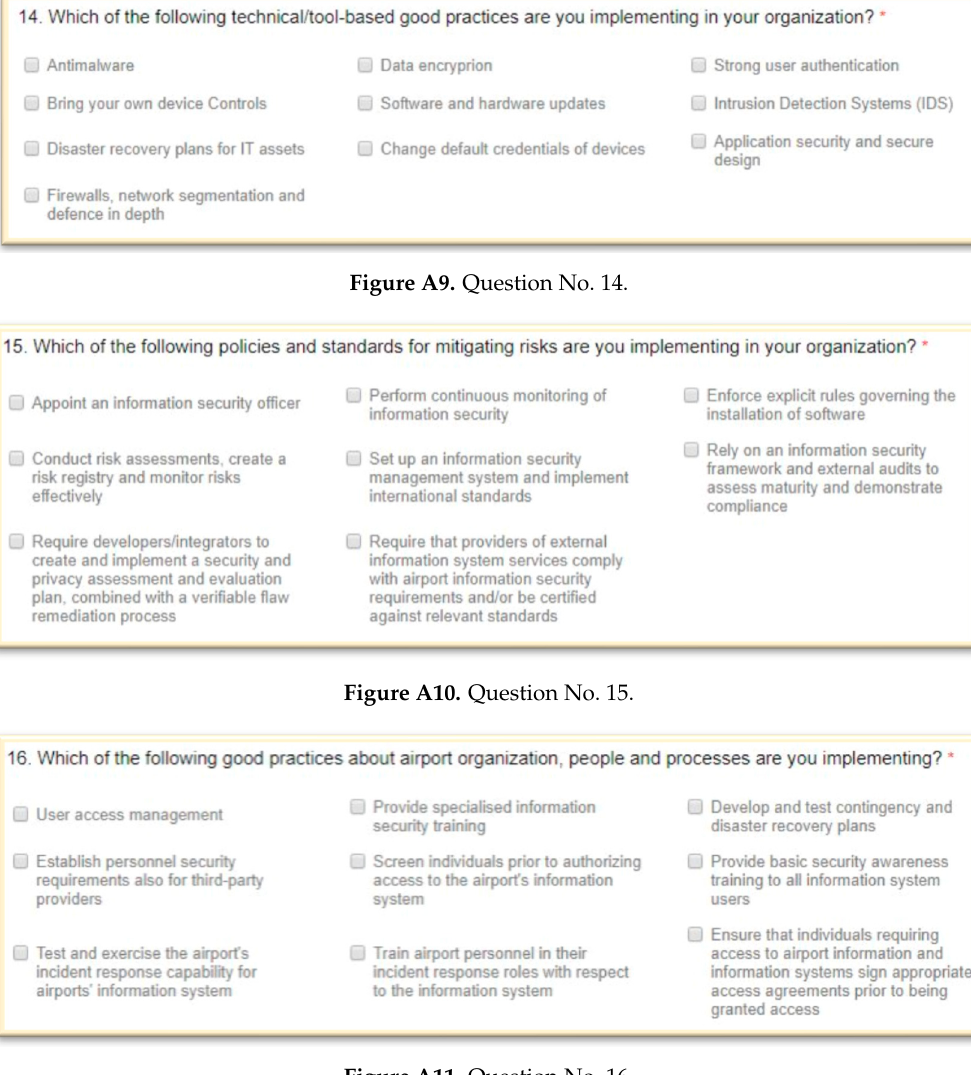
Figure A11. Question No 16. Table A1. Origin of airports’ answering & airport’s